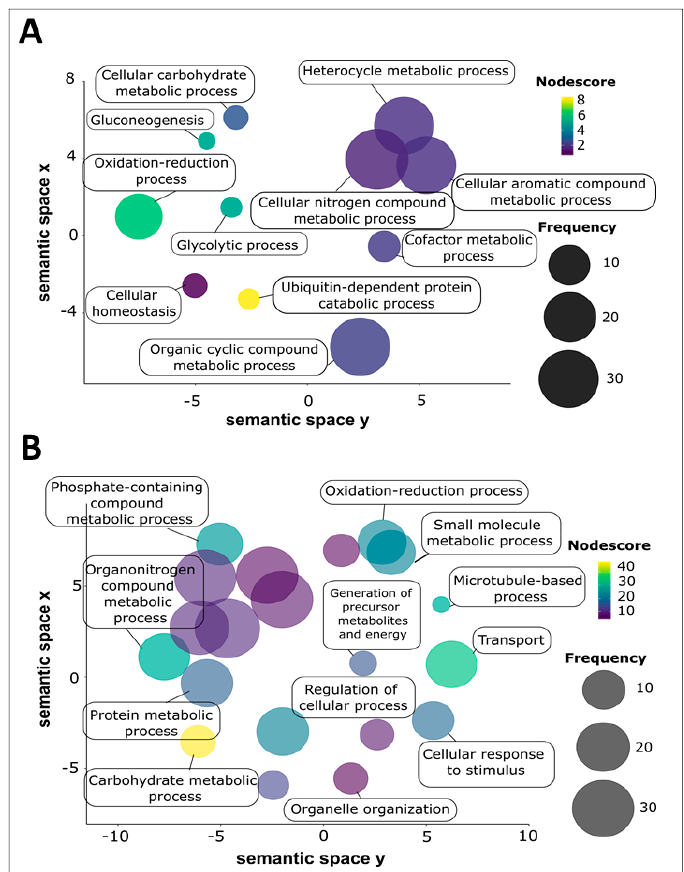
Figure 3. Biological process GO term categories of adult Schistosoma haematobium vesicle proteins. Biological processes were ranked by nodescore (Blast2GO) and plotted using REViGO. Semantically similar GO terms plot close together, increasing heatmap score signifies increasing nodescore from Blast2GO, while circle size denotes the frequency of the GO term from the underlying database. ( A ) 120k pellet vesicles, ( B ) 15k pellet vesicles.